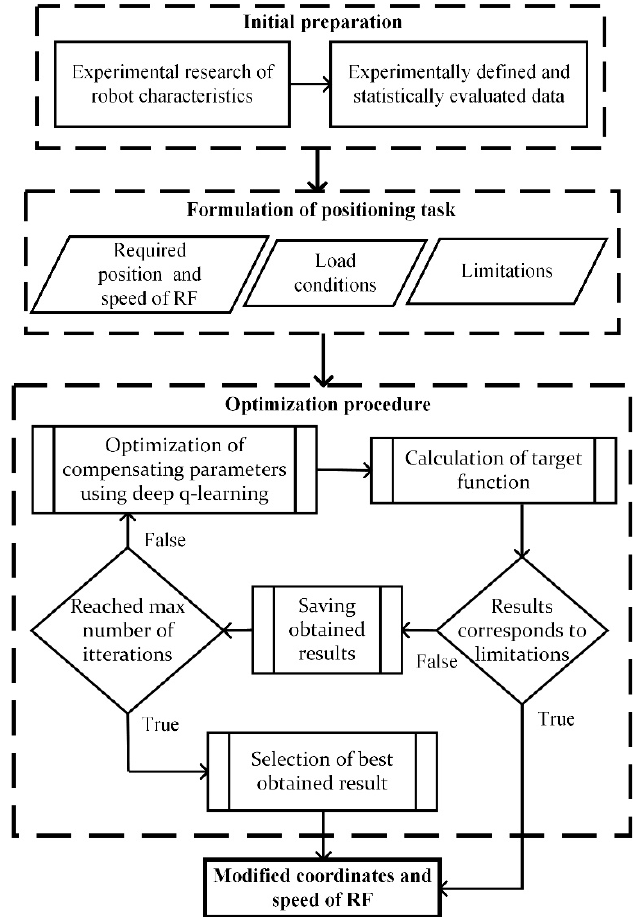
Figure 1. Simplified block diagram of positioning accuracy increase procedure by implementing ML method. RF—reference point.